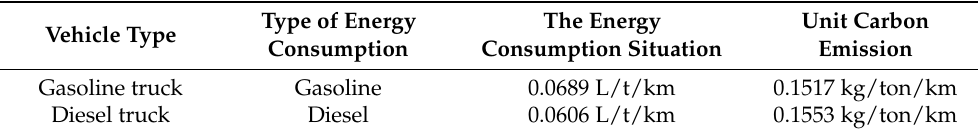
Table 1. Emission coefficients related to the road transport industry. Type of Vehicle Type